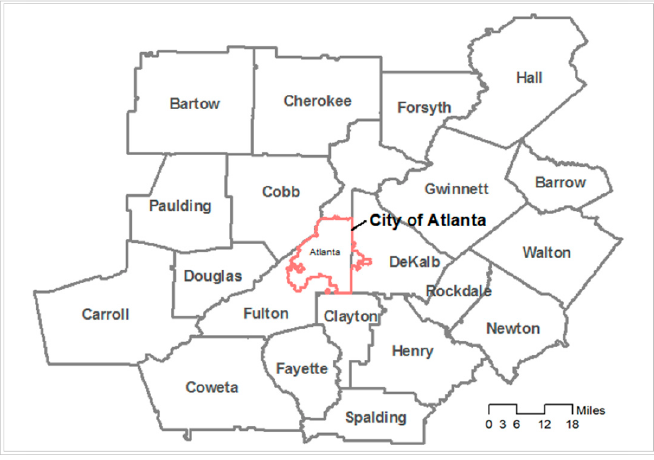
Figure 1. The study area (the Atlanta metropolitan area).